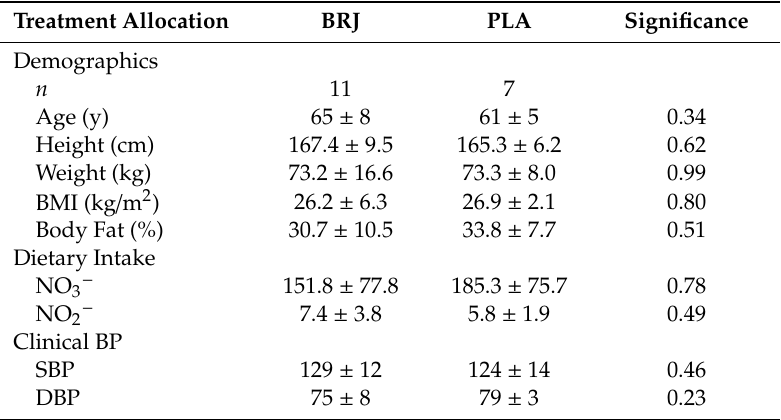
Table 1. Baseline characteristics stratified by treatment allocation.